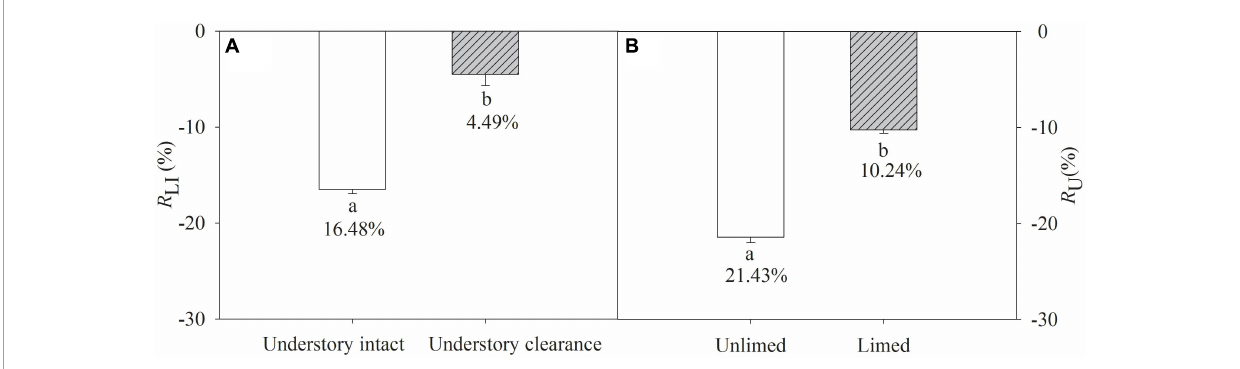
FIGURE2 (A) Proportions of lime application induced soil respiration to total soil respiration ( R LI ) in the presence and absence of understory vegetation; (B) proportions of understory removal caused changes in soil respiration to total soil respiration ( R U ) in unlimed and limed soil. Values are means with standard errors, n = 3. Different lowercase letters indicate significant difference ( P ≤